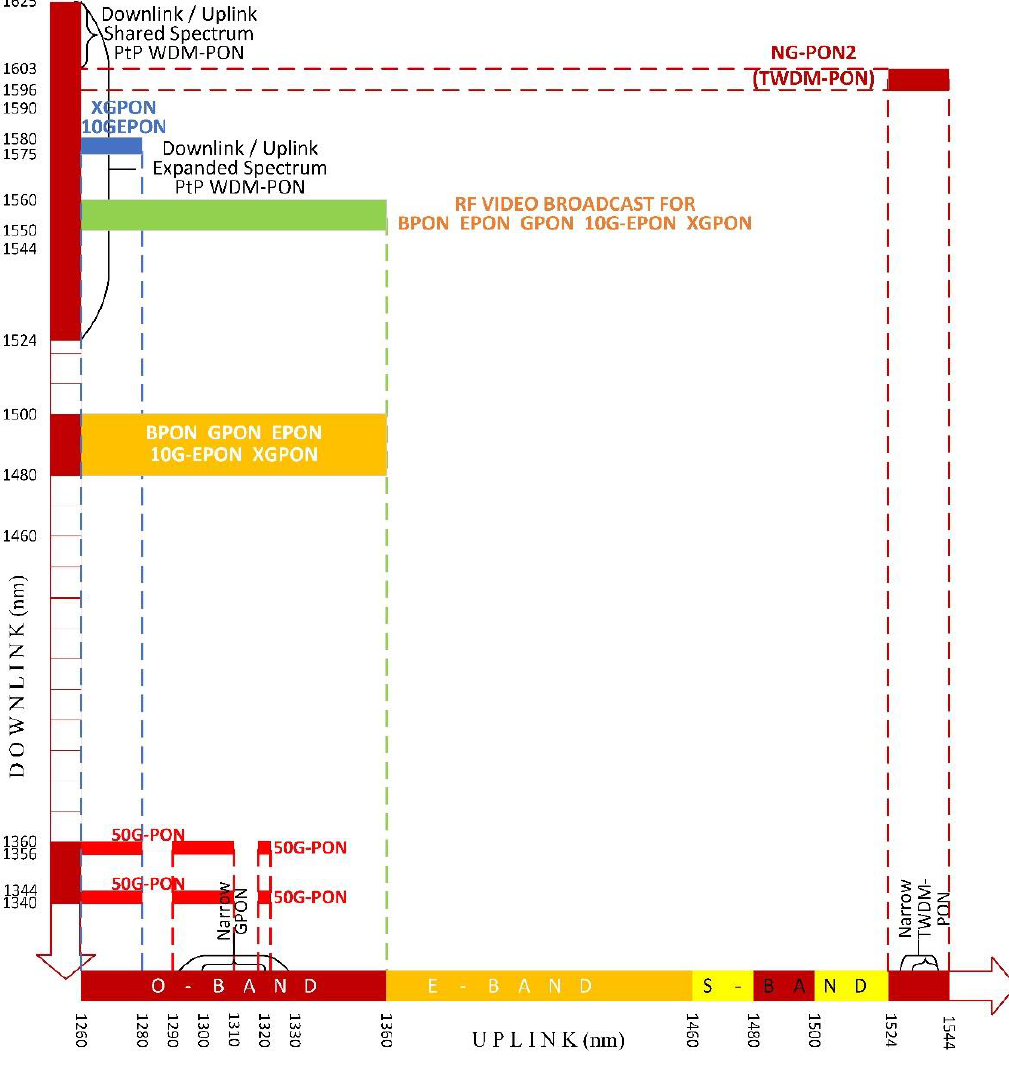
Figure 11. The wavelength chart of PONs (The deep red parts of the axes, uplink — downlink, denote occupied wavelengths). Table 7. A PON Comparison.